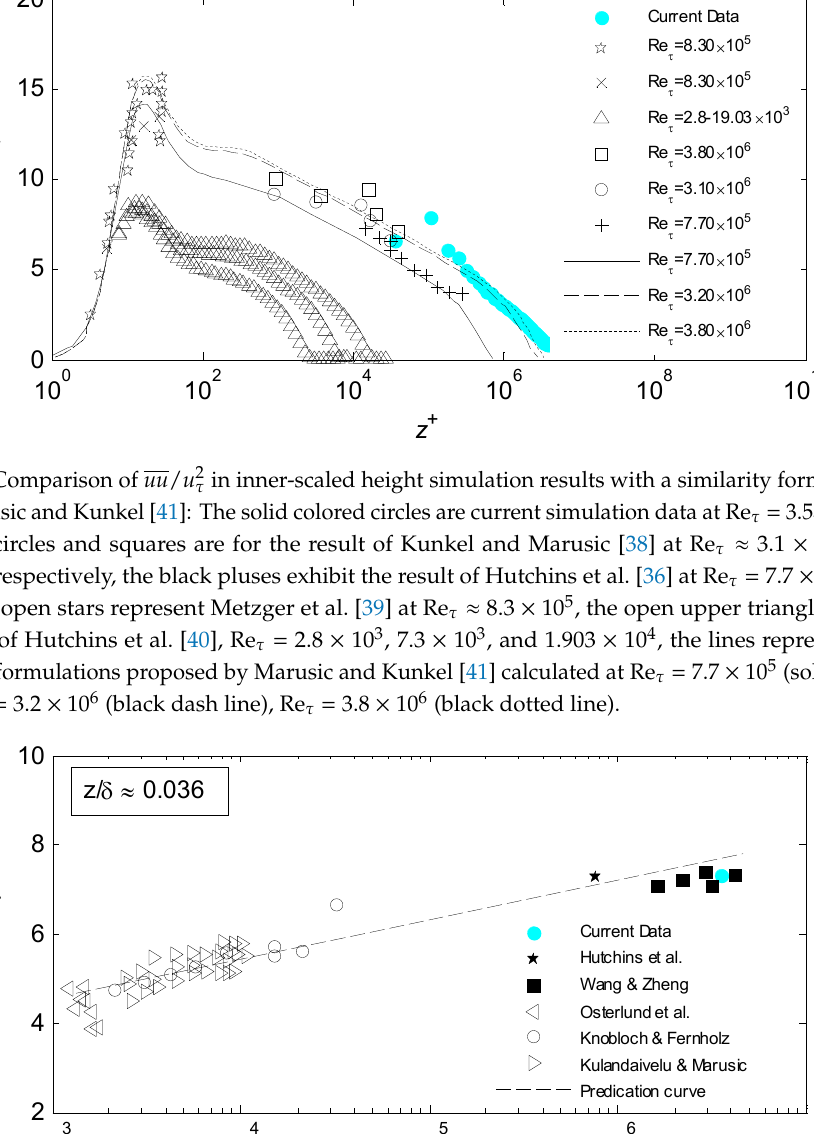
Figure 5. Variation of normalized streamwise component of normal stress uu / u 2 τ with the Reynolds